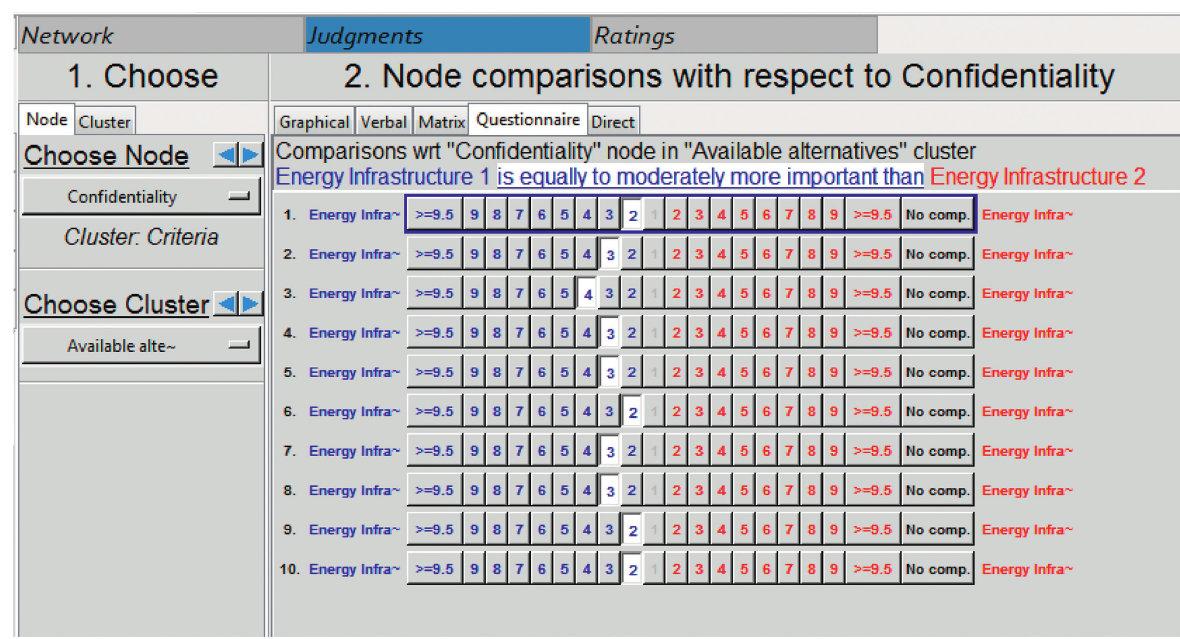
Figure 2: Comparisons of the criteria (features) with respect to the available alternatives.